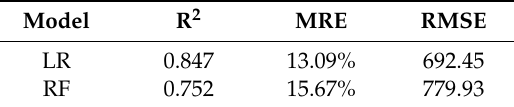
Table 6. Model accuracy in sparse area.